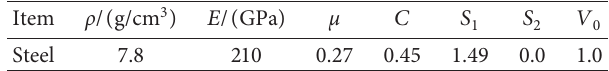
Table 3: Parameters of the related steel